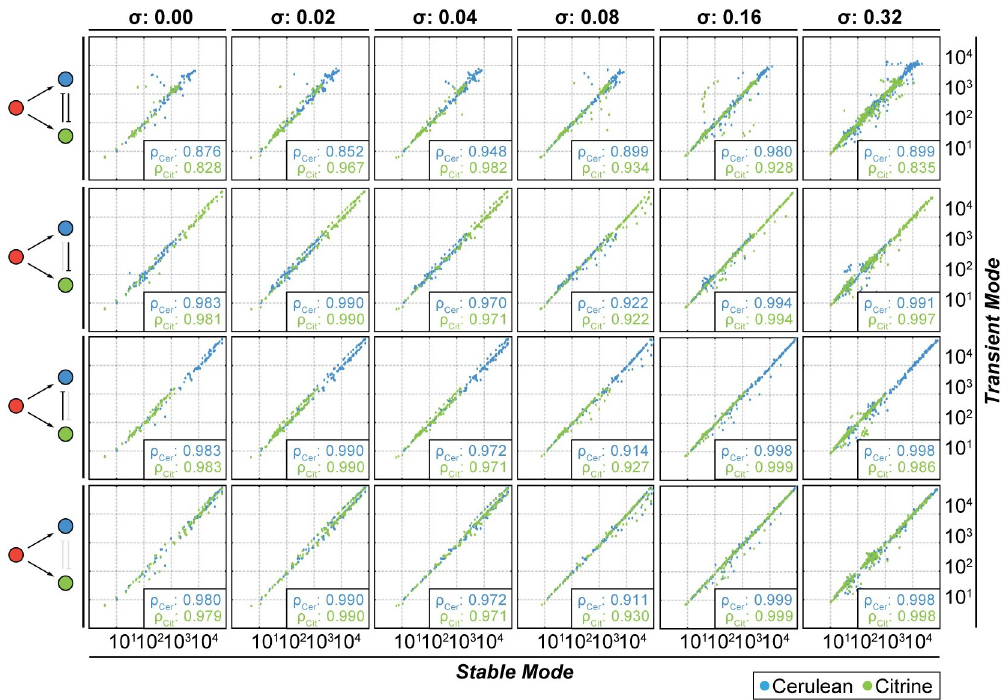
Fig 7. Quantitative analysis of the stable integration and transient transfection data sets. Correlation between extracted output modes of stable integration simulation and PFAFF results from transient transfection simulations. The mode values for both output colors (Cerulean and Citrine) for all input modulator levels and for all bins/stable copy number sets are plotted, and Pearson correlation coefficient ( ρ or ρ ) is shown for each Cer Cit